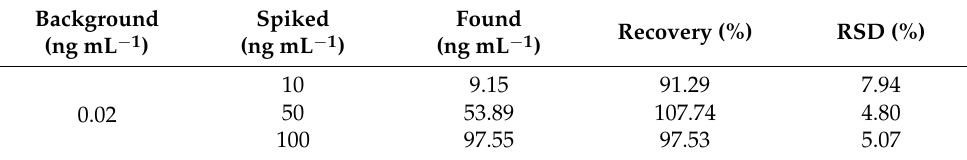
Table 3. Determination of Cd 2+ in environmental water samples (n ≥